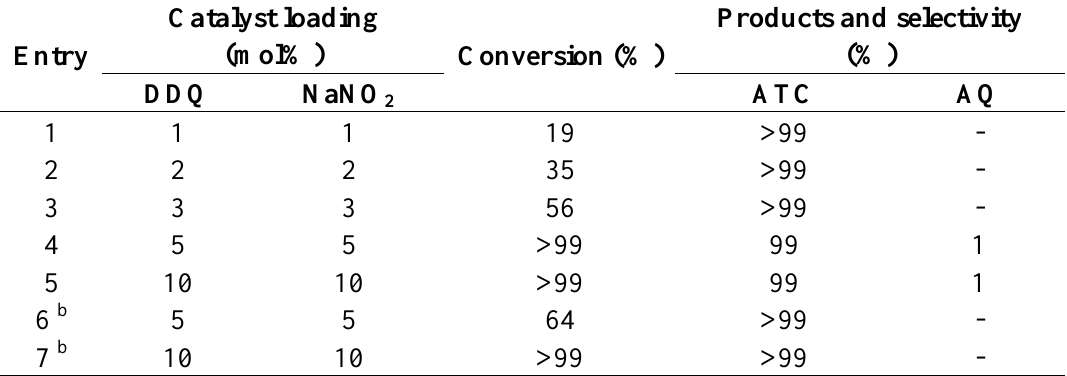
Table 1 . Effect of catalyst loading amount on the oxidative dehydrogenation of 9,10- dihydroanthracene to anthracene a